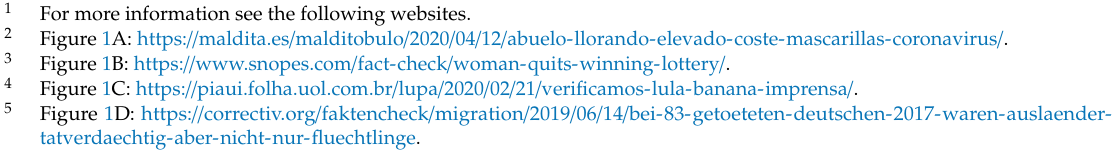
Figure 1A: https: // maldita.es / malditobulo / 2020 / 04 / 12 / abuelo-llorando-elevado-coste-mascarillas-coronavirus / . 3 Figure 1B: https: // www.snopes.com / fact-check / woman-quits-winning-lottery / . Figure 1A:https://maldita.es/malditobulo/2020/04/12/abuelo-llorando-elevado-coste-mascarillas- 4 Figure 1C: https: // piaui.folha.uol.com.br / lupa / 2020 / 02 / 21 / verificamos-lula-banana-imprensa / . coronavirus/. 5 Figure 1D: https: // correctiv.org / faktencheck / migration / 2019 / 06 / 14 / bei-83-getoeteten-deutschen-2017-waren-auslaender- Figure 1B: https://www.snopes.com/fact-check/woman-quits-winning-lottery/. Figure 1C: https://piaui.folha.uol.com.br/lupa/2020/02/21/verificamos-lula-banana-imprensa/. Figure 1D: https://correctiv.org/faktencheck/migration/2019/06/14/bei-83-getoeteten-deutschen-2017-waren- auslaender-tatverdaechtig-aber-nicht-nur-fluechtlinge.